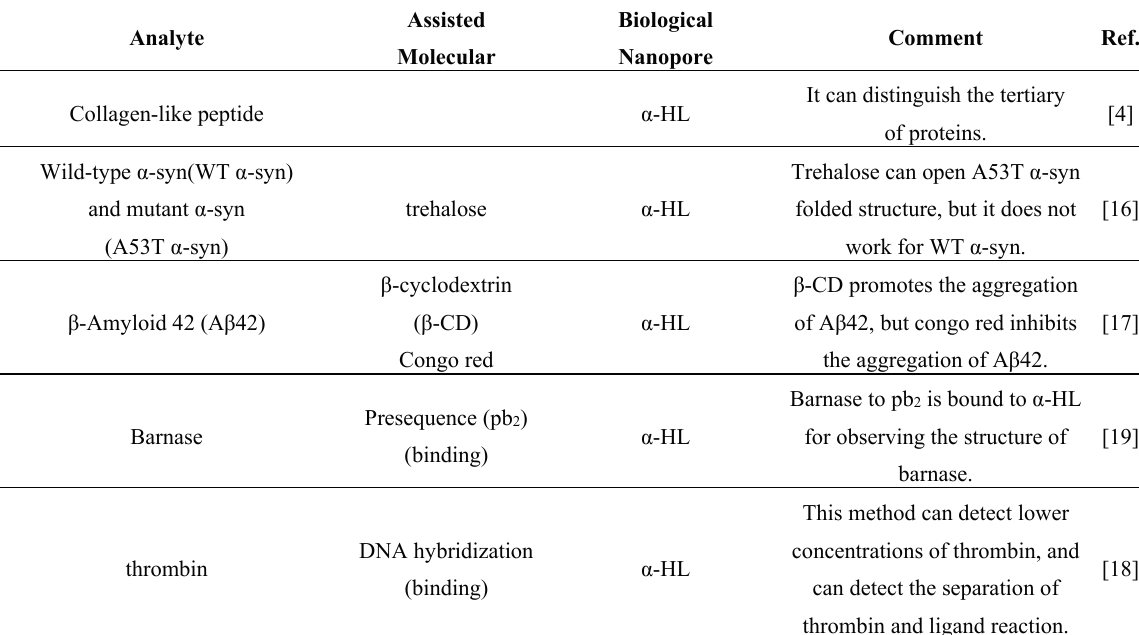
Table 1. Detection of proteins with biological